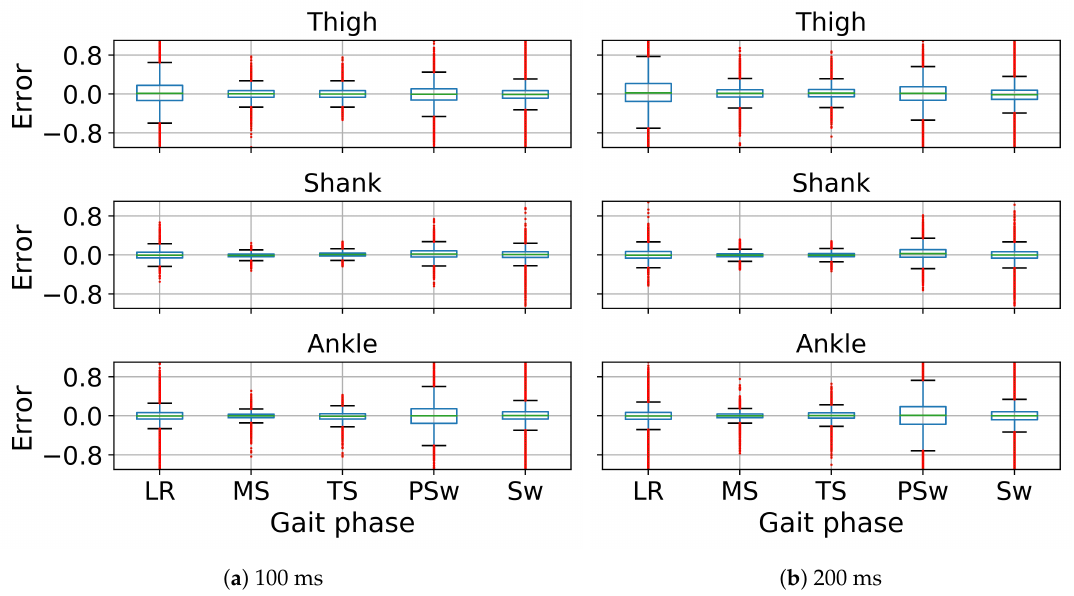
Figure 7. Error of z-score normalized angular velocities of ipsilateral thigh, shank and foot segments in 100 ms ( a ) and 200 ms ( b ) ahead prediction with respect to gait phases in intra-subject implementation. All angular velocity values shown are normalized to have zero mean and unit variance. The line inside the box represents the median error. The box represents the middle 50% of the error. The whiskers represent the ranges for the bottom 25% and the top 25% of the error, excluding outliers. The red tails indicate the